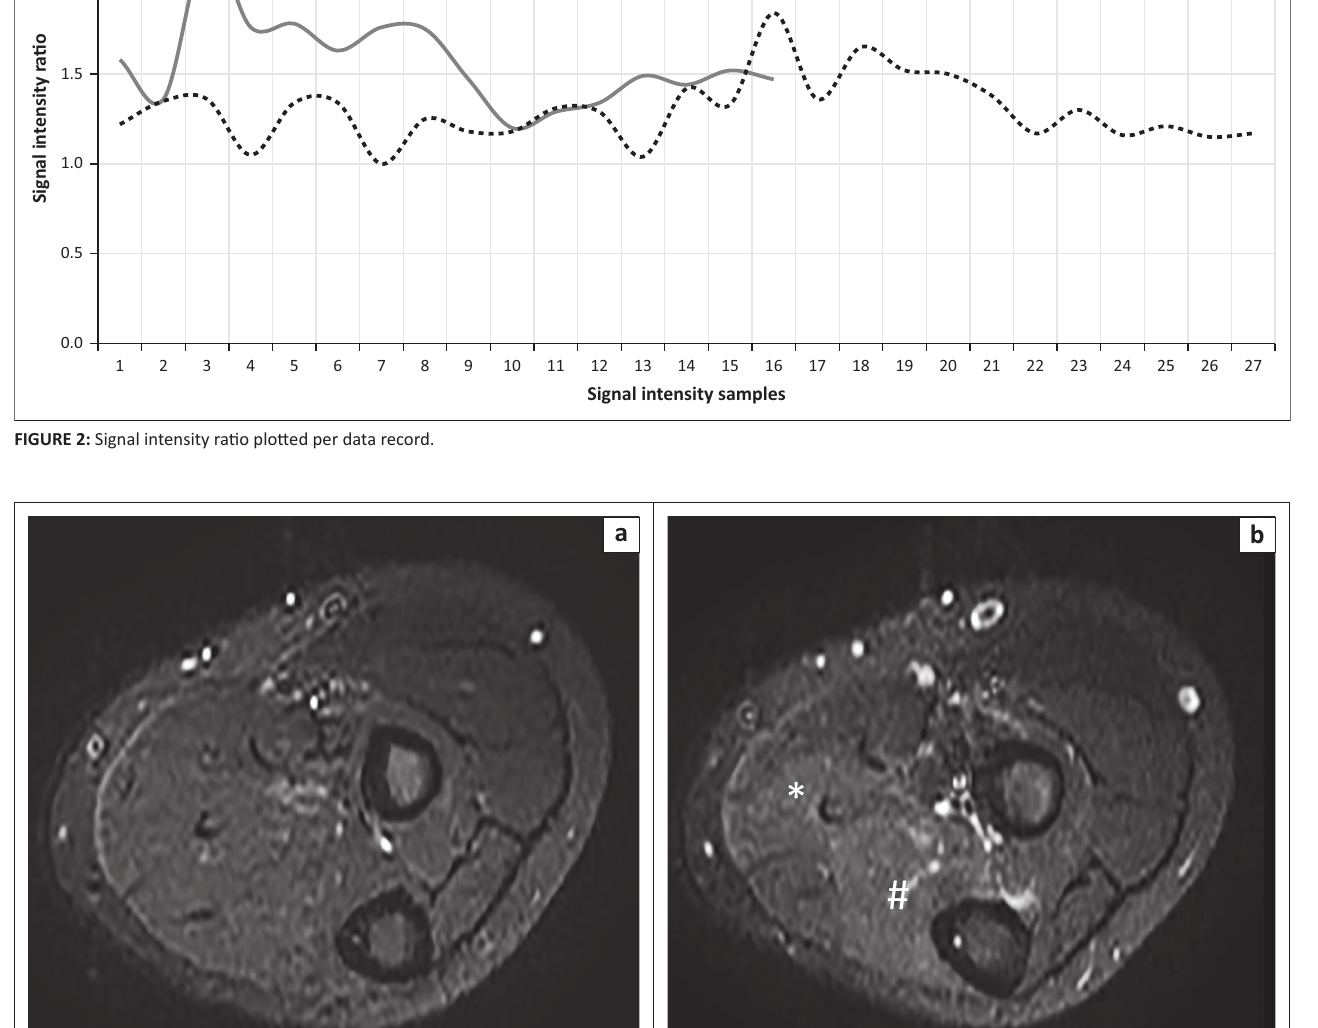
FIGURE 3: Pre-exercise (a) and post-exercise (b) sequences in a control subject revealing subtle increases in signal within the flexor digitorum superficialis ( * ) and flexor digitorum profundus (#)